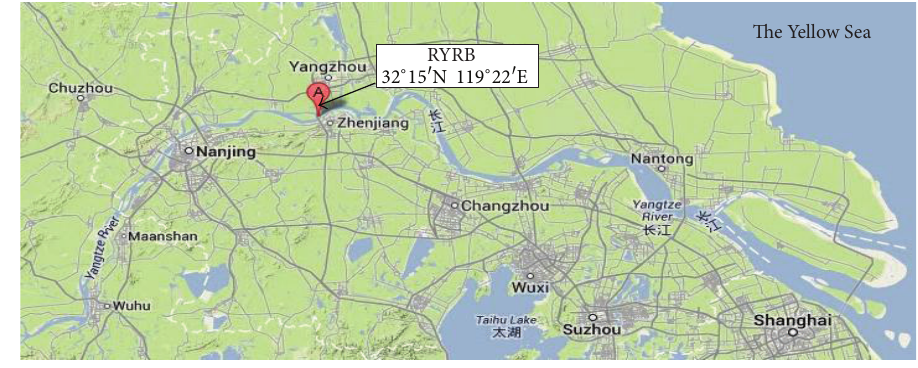
Figure 1: Geographical location of